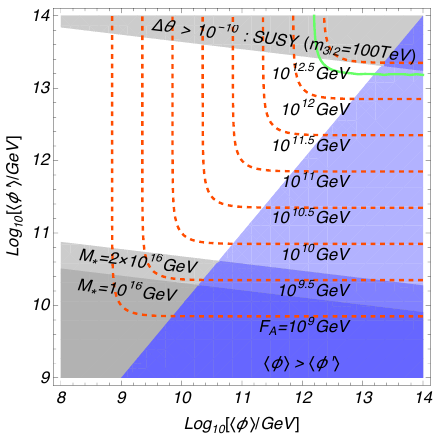
Figure 2 . The constraint on the VEVs of (cid:30) and (cid:30) 0 for the SUSY extension. The gray shaded upper region is excluded for the SUSY model with m = 100 TeV (see eq. (5.4)). The orange lines 3 = 2 are the contours of the e(cid:11)ective decay constant F A . In the blue shaded region, h (cid:30) i > h (cid:30) 0 i . The gray shaded lower regions are excluded as the gauge coupling constants become non-perturbative below the GUT scale. The thin green region is excluded by the Axion Dark Matter eXperiment (ADMX) [64] where the dark matter density is assumed to be dominated by the relic